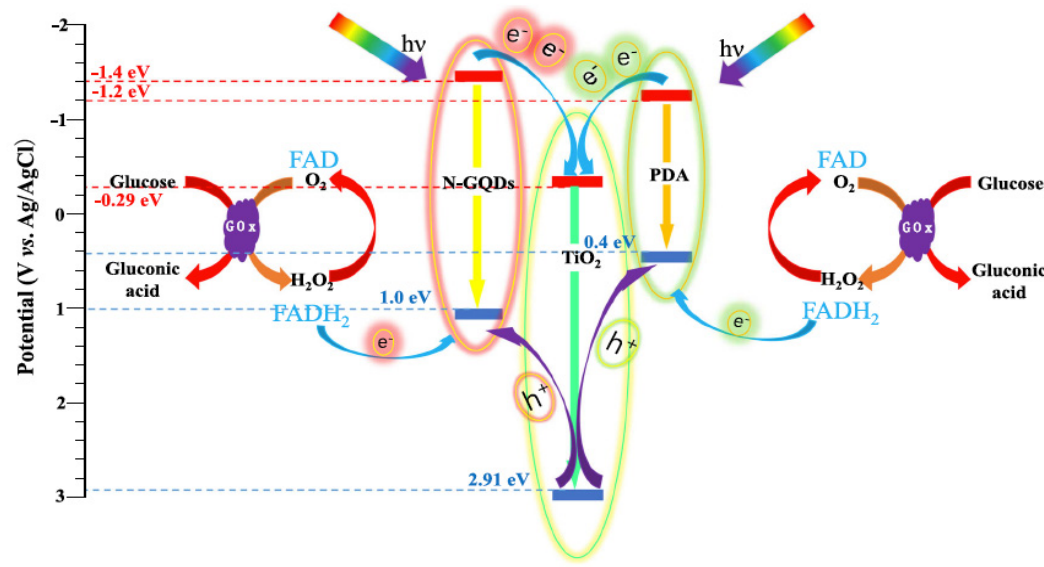
Figure 33. Sensing mechanism of TiO 2 /dopamine/GQD/GOx nanocomposite dual-electron-acceptor biosensor. Figure 33 reprinted from [76]. Copyright 2020 Springer Nature.